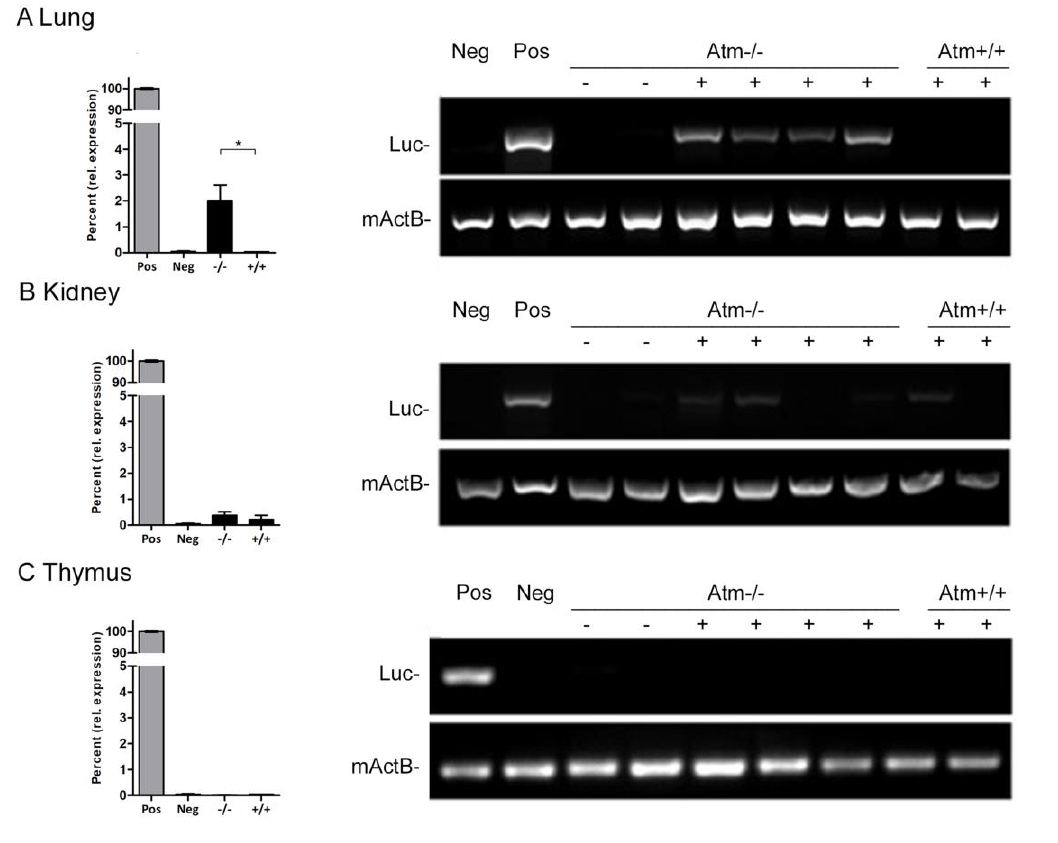
Figure 3. Detection of Luc + mASCs on day 15 after transplantation of Atm -deficient ( Atm − / − , n = 4) and wild type mice ( Atm +/+ , n = 3) knock-out using PCR. Quantitative analysis of the relative expression (expressed as percent; MW ± SEM) (left side) and results of the gel electrophoresis of lungs, kidney, and thymus (right side). Controls: RNA from Luc negative tissue (Neg), RNA from Luc positive tissue (Pos = 100%). Luc = luciferase, mActB = murine actine-beta. * p < 0.05.